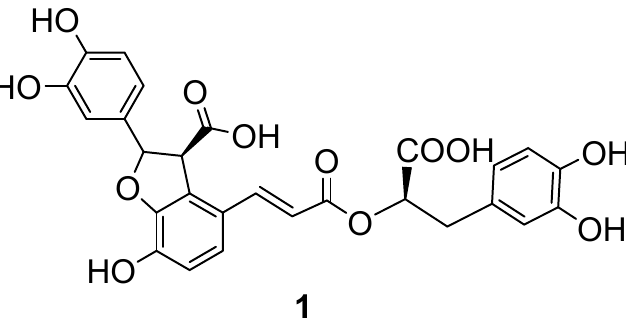
Figure 1. Structure of lithospermic acid isolated from Salvia miltiorrhiza .